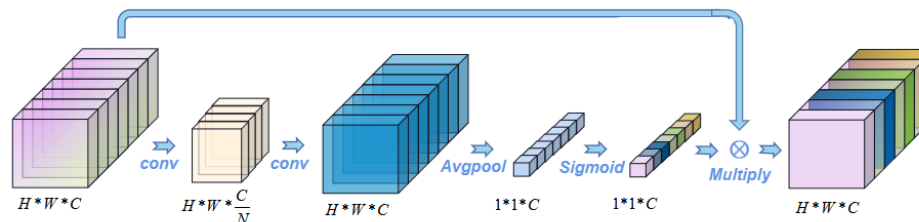
Figure 3. Channel attention